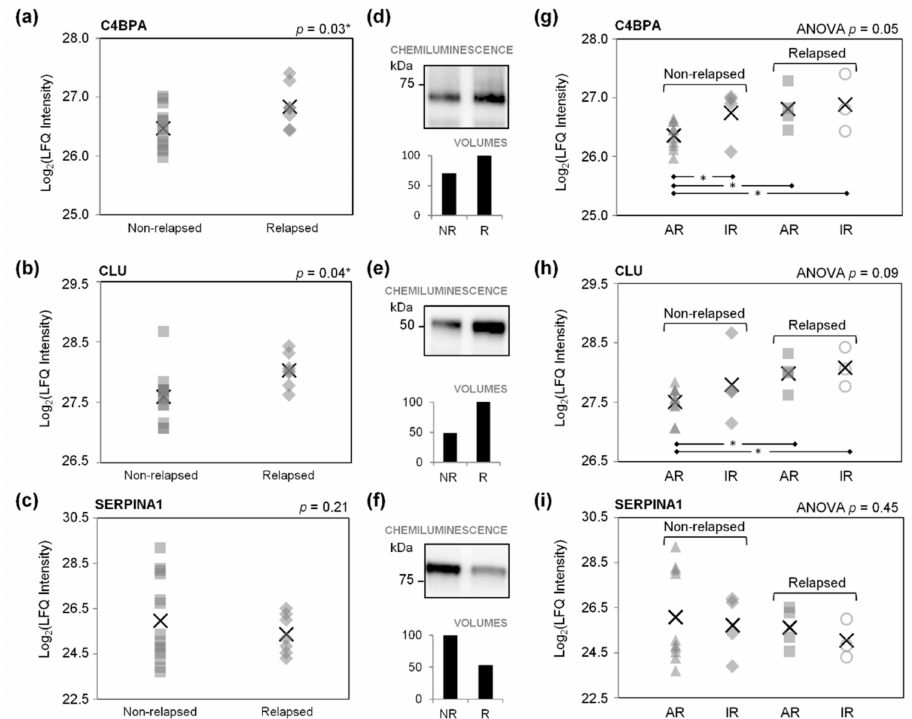
Figure 3. Abundance of C4b-binding protein α chain (C4BPA), clusterin (CLU), and α -1-antitrysin (SERPINA1) in pediatric/adolescent patients with non-relapsed (NR) and relapsed (R) HL (validation phase). Non-relapsed and relapsed patients were divided according to whether or not they had an adequate (AR) or inadequate (IR) response to therapy on early response assessment, as explained in the Materials and Methods. Data are expressed as LFQ values obtained with LC-MS/MS ( a – c , g – i ), or as band intensities from immunoblotting ( d – f ). In ( a – c , g – i ), the crosses indicate the mean value of the parameter tested, and the other symbols (squares, rhombuses, triangles, and circles) indicate individual patients. * Significance for p -value < 0.05. NR, non-relapsed; R, relapsed. In Part III, differences in the abundance of C4BPA and CLU were examined by